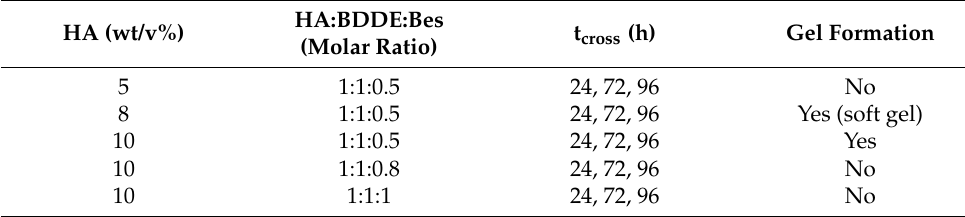
Table 1. Preliminary conditions used to optimize the crosslinking reactions.